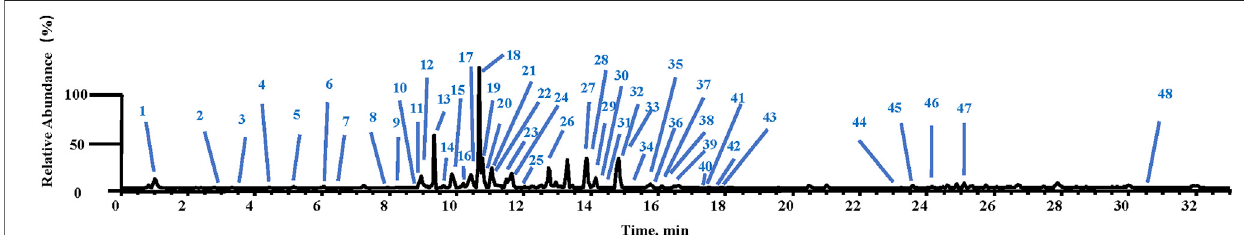
FIGURE 2 | The total ion chromatogram of ARF.